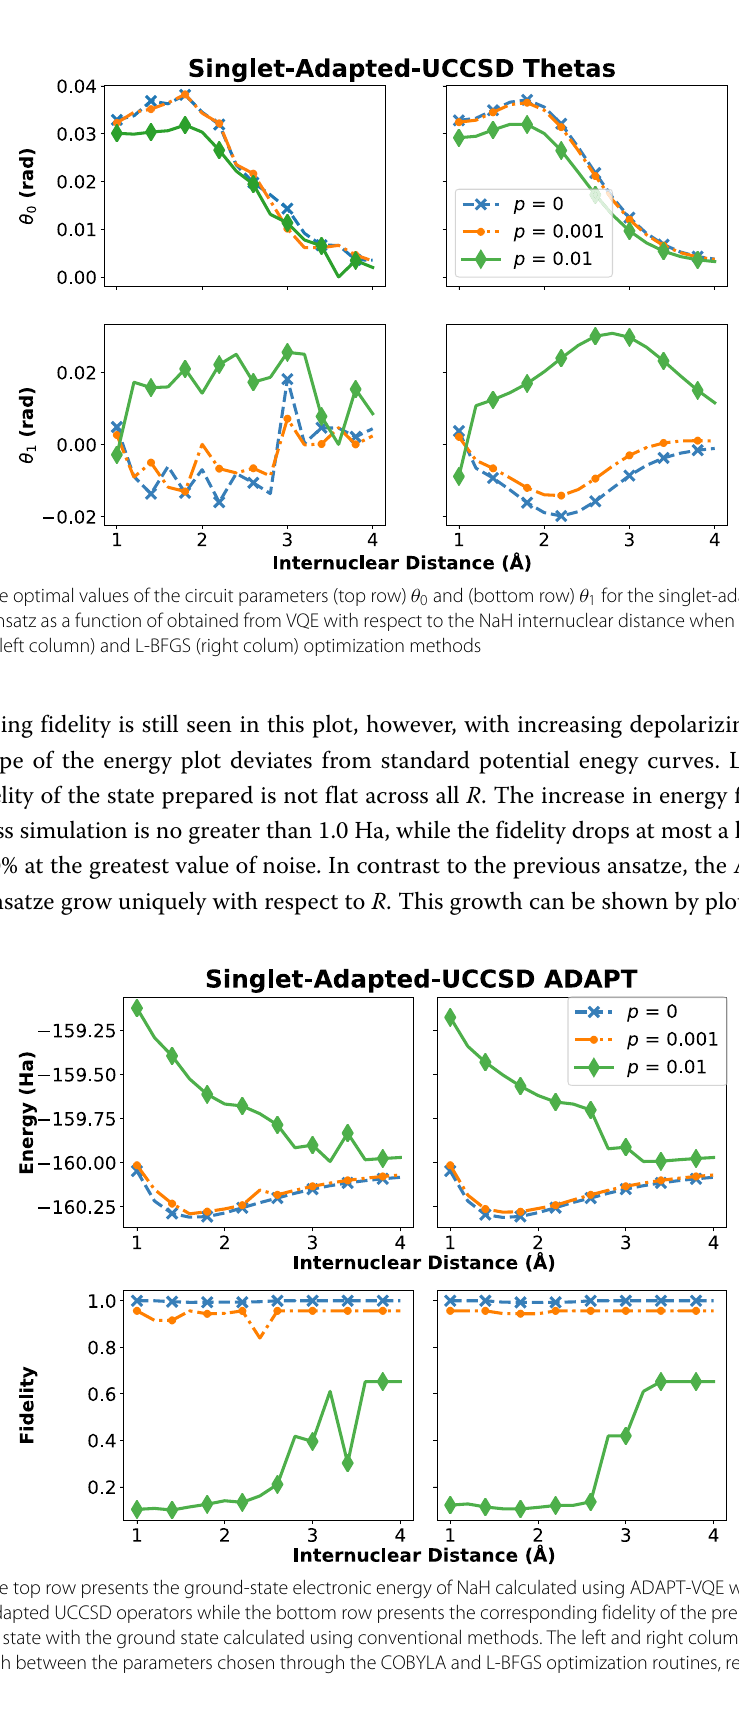
Fig. 8 The top row presents the ground-state electronic energy of NaH calculated using ADAPT-VQE with singlet-adapted UCCSD operators while the bottom row presents the corresponding fidelity of the prepared quantum state with the ground state calculated using conventional methods. The left and right columns distinguish between the parameters chosen through the COBYLA and L-BFGS optimization routines,